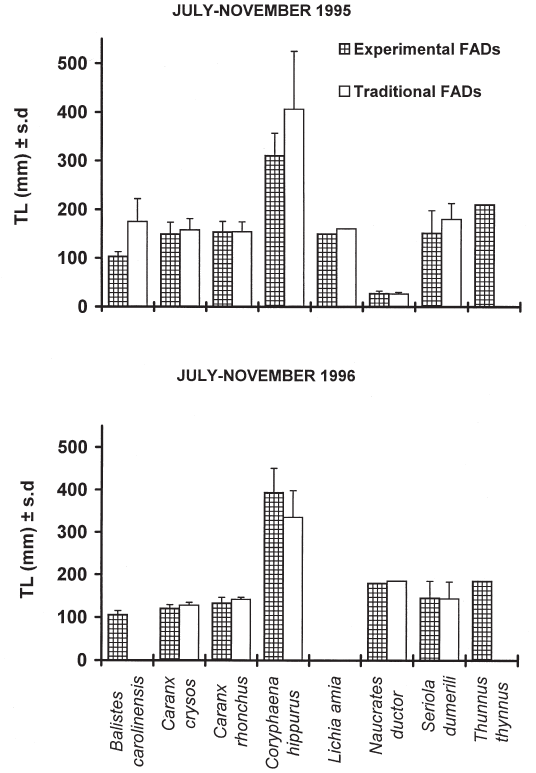
F IG . 6. – Average total length (TL) and standard deviation (s.d.) of species caught at the two types of